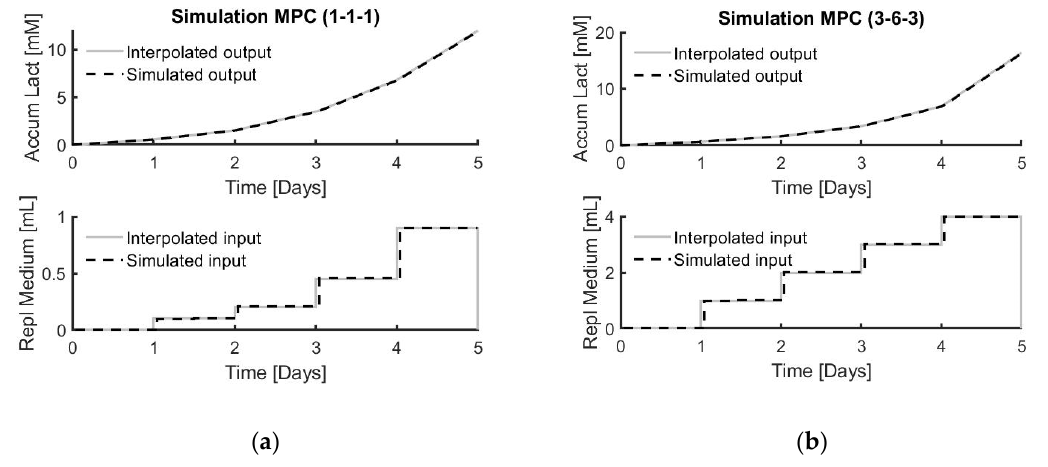
Figure 7. Top graph shows the interpolated output (accumulated lactate (mM)) compared to the simulated output. Bottom graph represents the interpolated input (total replaced medium (mL)) compared to the simulated input. ( a ) model-based predictive control (MPC) simulation applied to donor 1, condition 1 and triplicate 1; ( b ) MPC simulation applied to donor 3, condition 6 and triplicate 3.